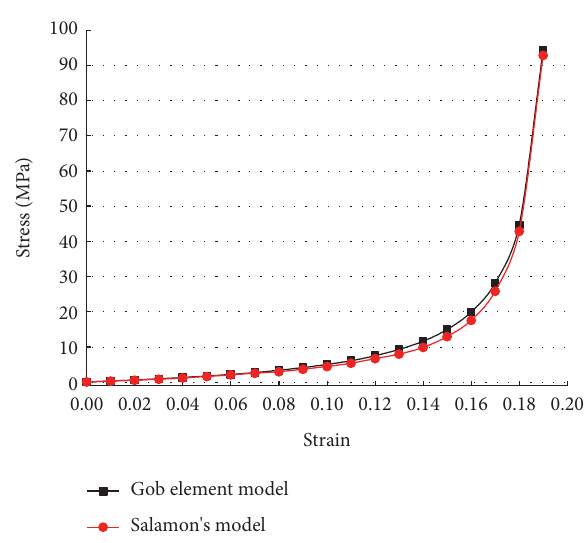
Figure 14: The stress-strain curve comparison of simulated and calculated